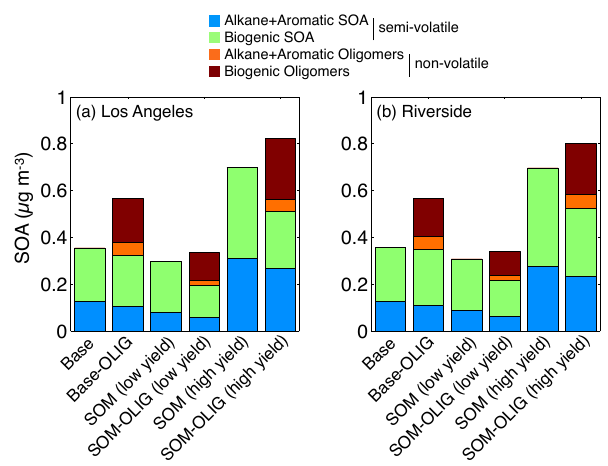
Figure 5: 14-day averaged SOA concentrations at (a) Los Angeles and (b) Riverside for the Base, Base- Figure 5. 14-day averaged SOA concentrations in SoCAB (a–c) OLIG, SOM, SOM-OLIG simulations resolved by the precursor/pathway. and the eastern USA (d–f) for the Base, COM and SOM simula- tions. The SOM results are averages of the low-yield and high-yield